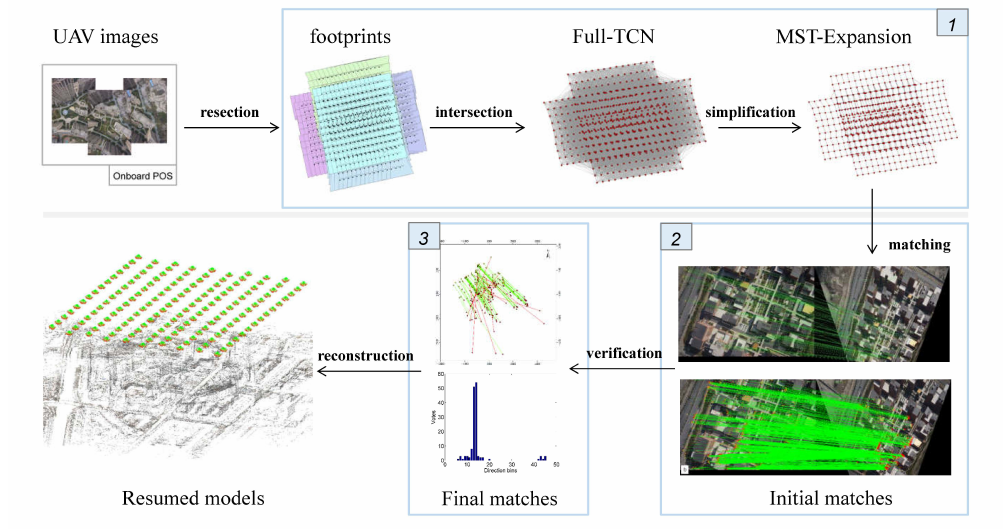
Figure 1. Overall workflow for efficient SfM of oblique UAV